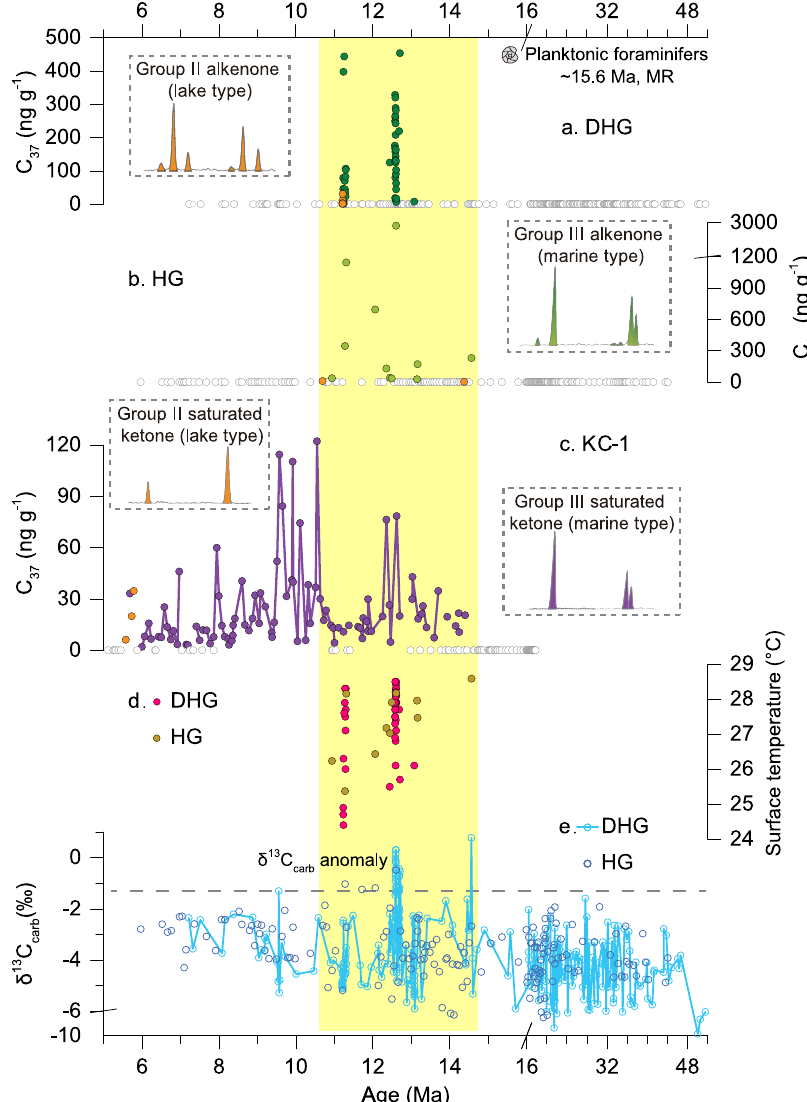
Fig. 2 Unusual geochemical signatures in the mid-Miocene strata of the Qaidam Basin. a , b Alkenone contents from the DHG and HG sections, respectively. c Saturated ketone contents from the KC-1 core 27 . d Surface water temperatures estimated from marine alkenones in the DHG and HG sections. e Carbonate δ 13 C records from the DHG and HG sections. The insets show representative gas chromatographs of unsaturated/saturated alkenones produced by Group III and II Isochrysidales. In ( a ‒ c ), green/light green/purple and orange fi lled circles indicate Group III and II Isochrysidales, respectively, while gray empty circles indicate analyzed samples with alkenones not detected. The yellow bar marks the mid-Miocene interval with unusual geochemical signatures identi fi ed across the basin, with the dashed line in ( e ) showing elevated δ 13 C values during this interval, based on the conventional chronology 22 . The fossil symbol indicates the reported planktonic foraminifers at ~15.6 Ma from the MR section in the southeastern Tarim Basin 17 . Note the condensed interval before 16